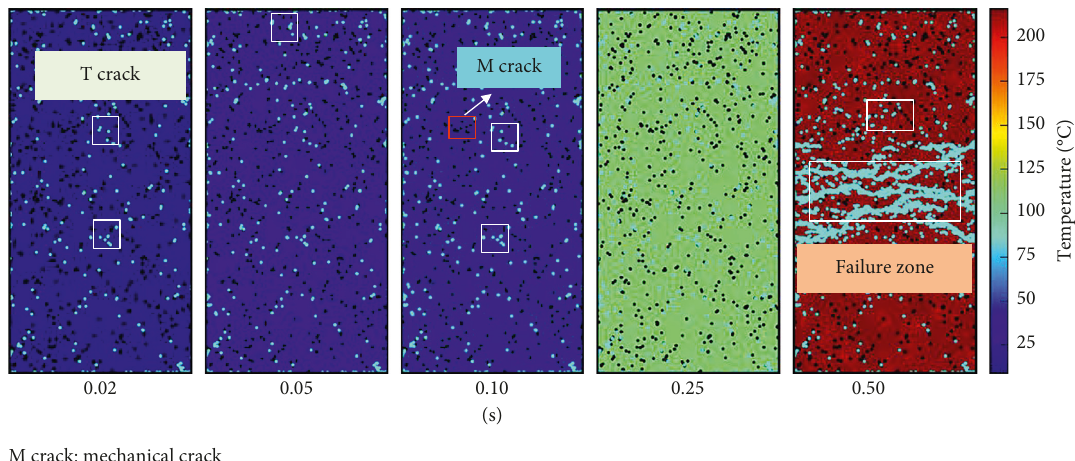
Figure 13: The failure characteristics under the different heating durations (3.0‰).